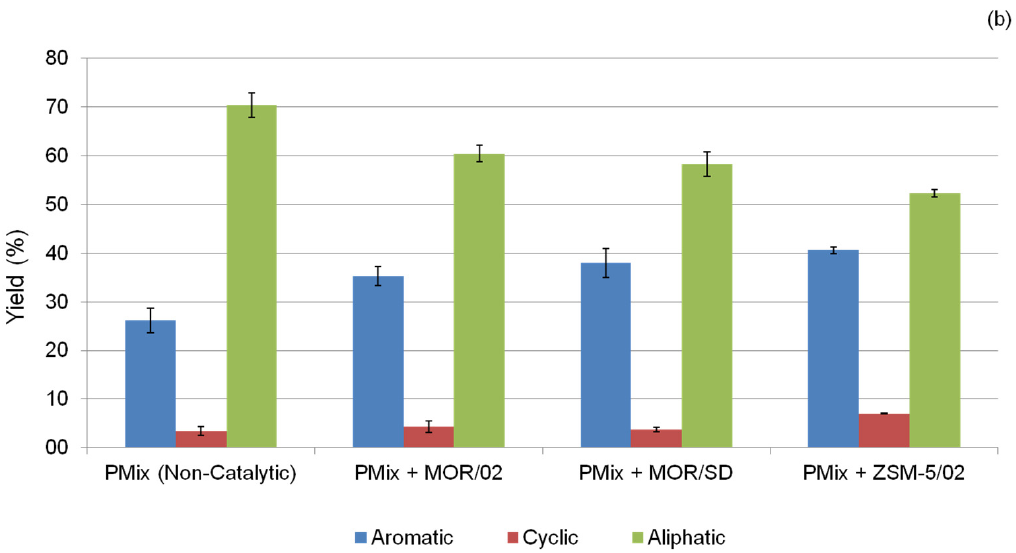
Figure 7. Composition of pyrolytic liquids in ( a ) aliphatic, cyclic and aromatic content in total product and ( b ) light fraction.